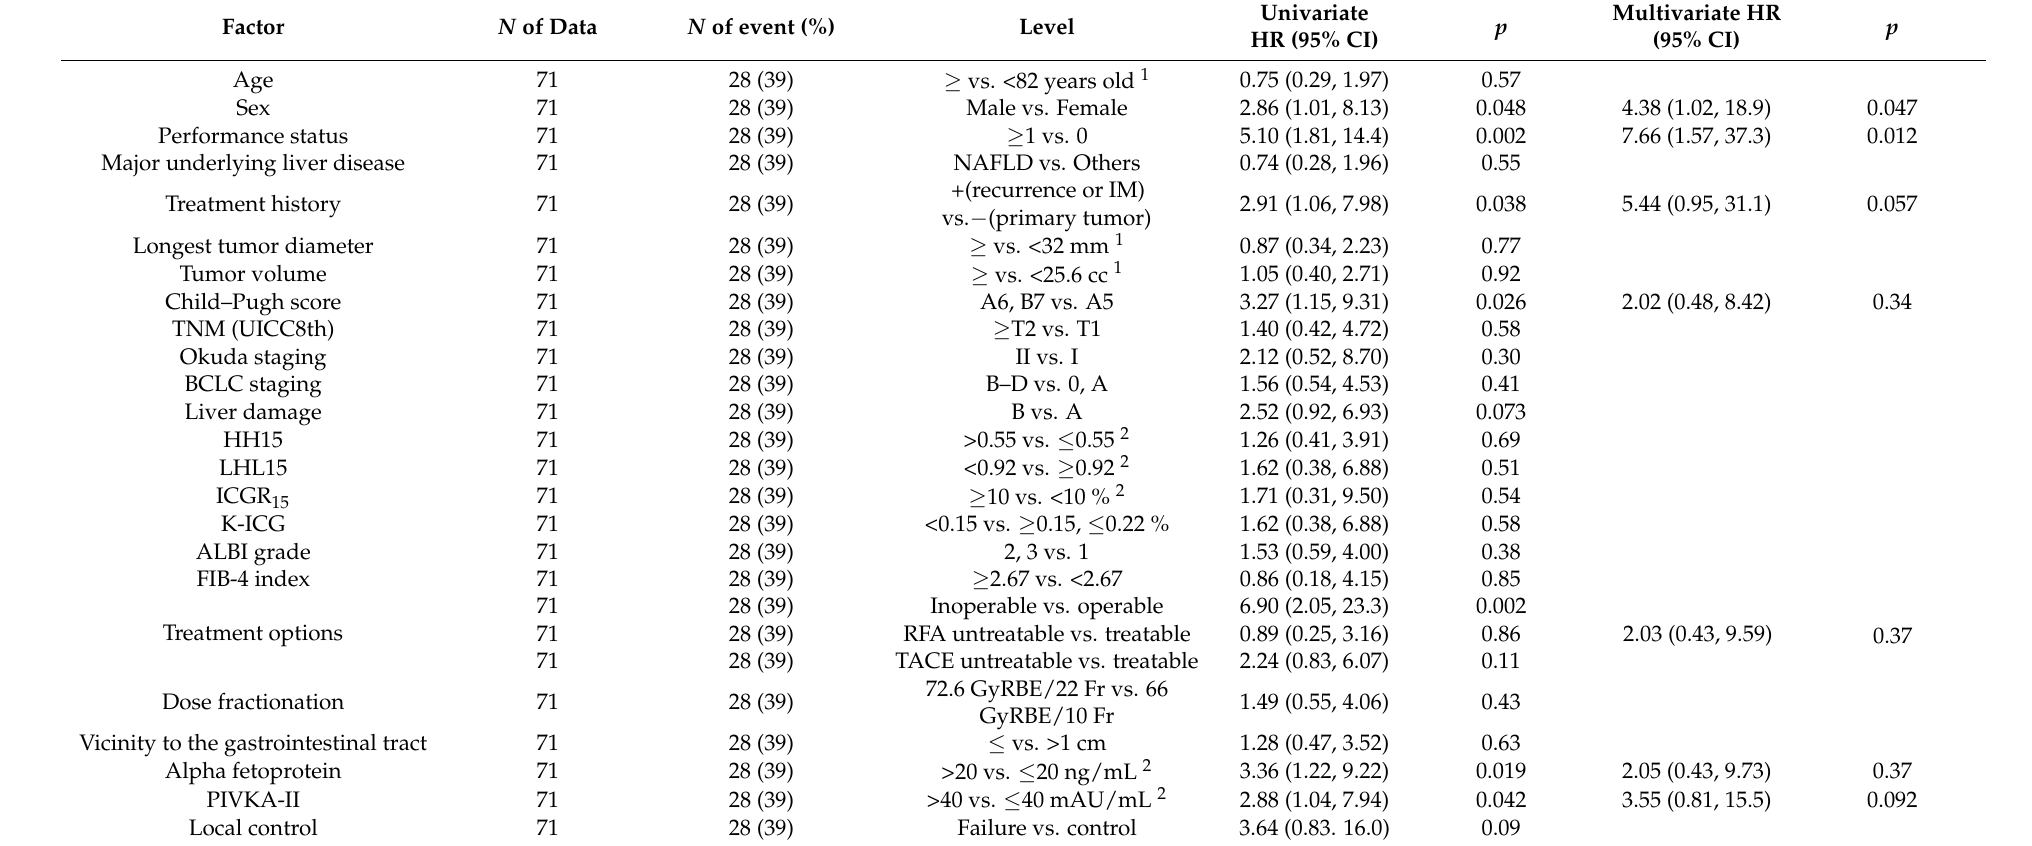
Table 3. Uni- and multivariate Cox’s analyses for overall